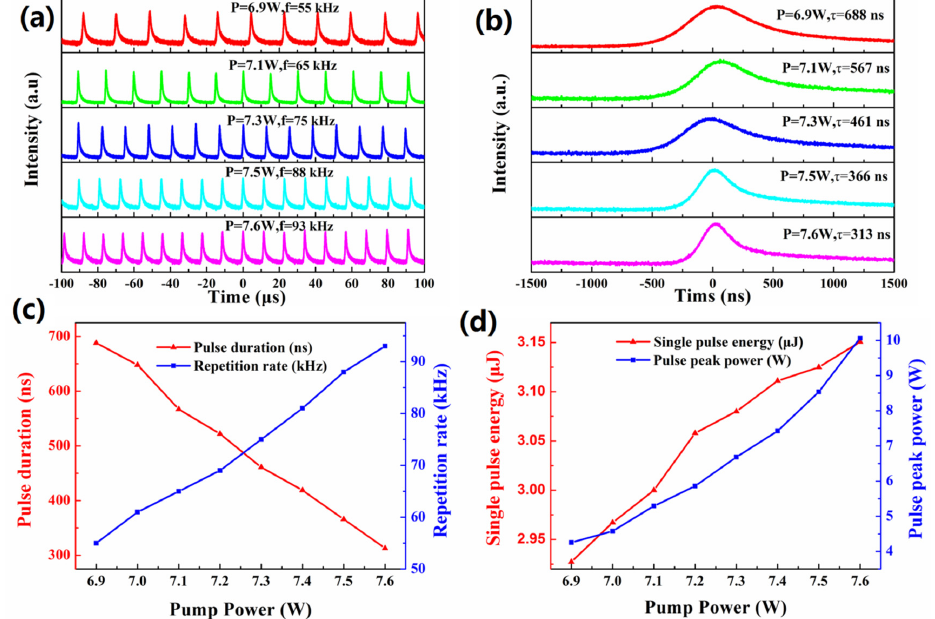
Table 1. Q-switched s lid-state lasers based on 2D SAs.